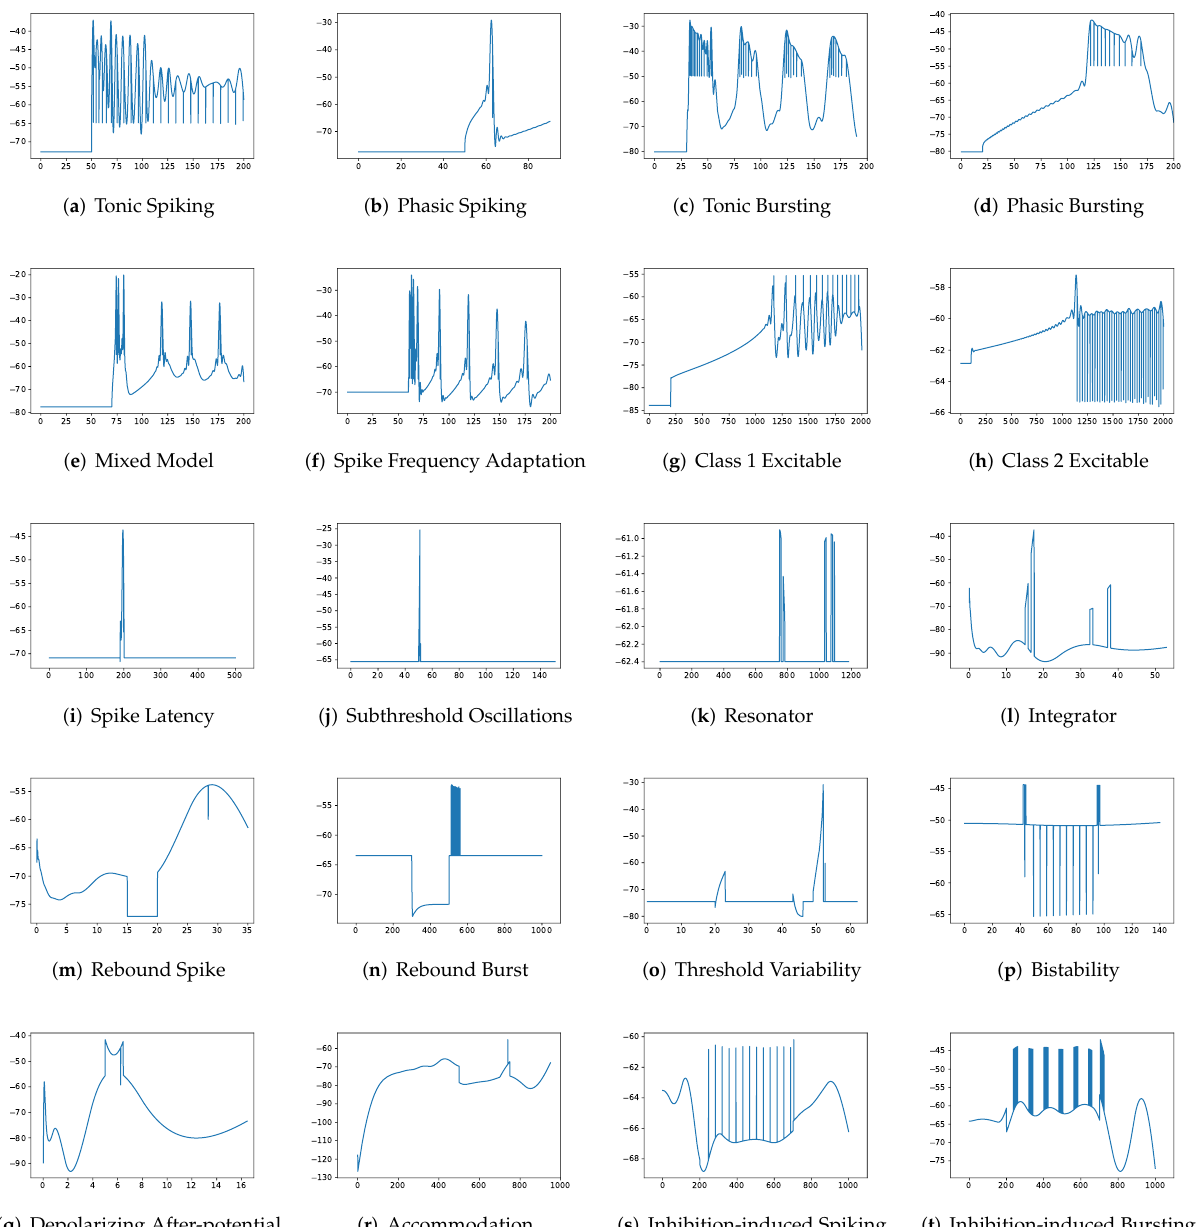
Figure 11. Membrane potentials of RCR, where y-axis is the membrane potential (mV) and x-axis is the time